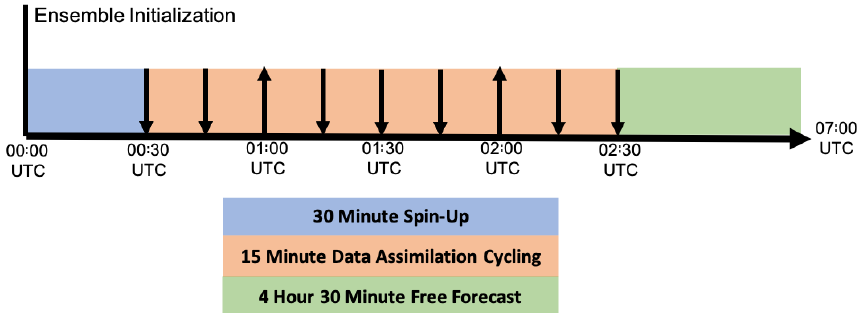
Figure 9. The OSSE data assimilation timeline. Downward-pointing arrows indicate times when only radar observations are assimilated. Upward arrows indicate when surface and radar observations are